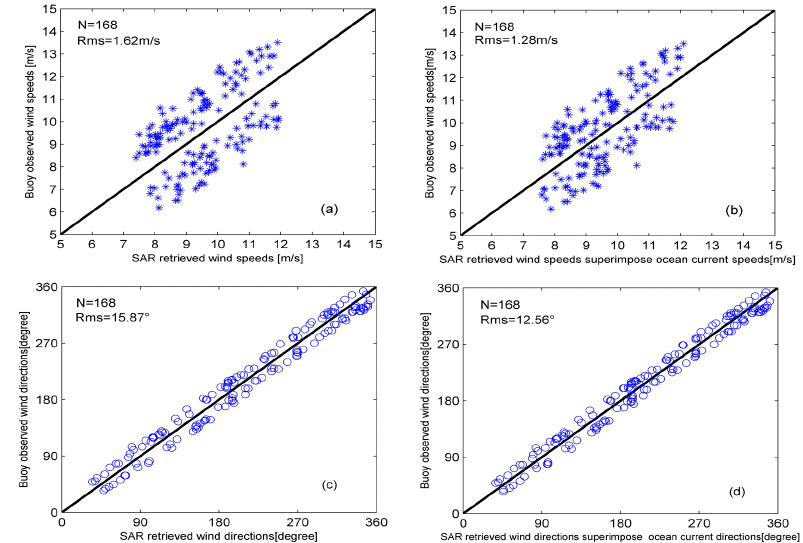
Figure 2. ( a ) SAR-retrieved wind speeds from C-2PO model compared to wind speeds observed by buoy measurements; ( b ) SAR-retrieved wind speeds with superimposed ocean current speeds compared to winds speeds observed by buoys; ( c ) SAR-retrieved wind directions derived from applying the C-2PO model compared to wind directions observed by buoys; ( d ) SAR-retrieved wind directions with superimposed ocean current directions compared to wind directions observed by buoys.